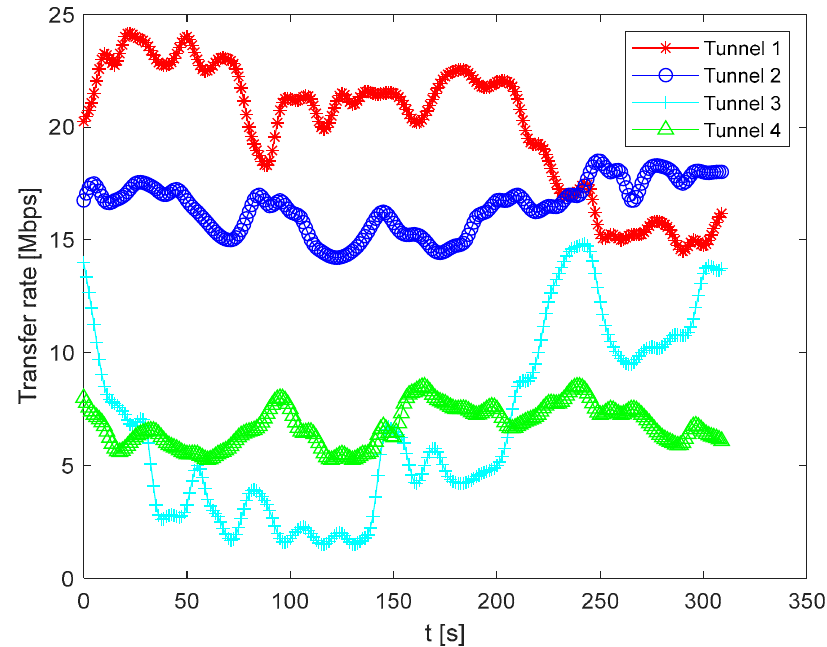
Figure 8. Variation in time of the capacity of the tunnels established over the macro cell wireless links.